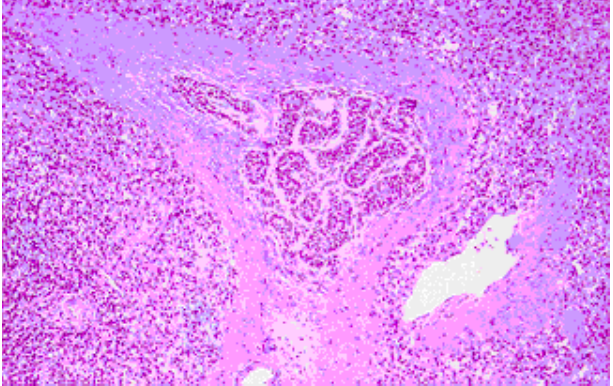
FIGURE 1D . An uncommon finding in splenogonadal fusion is the presence of a testicular inclusion composed of seminiferous tubules within the splenic